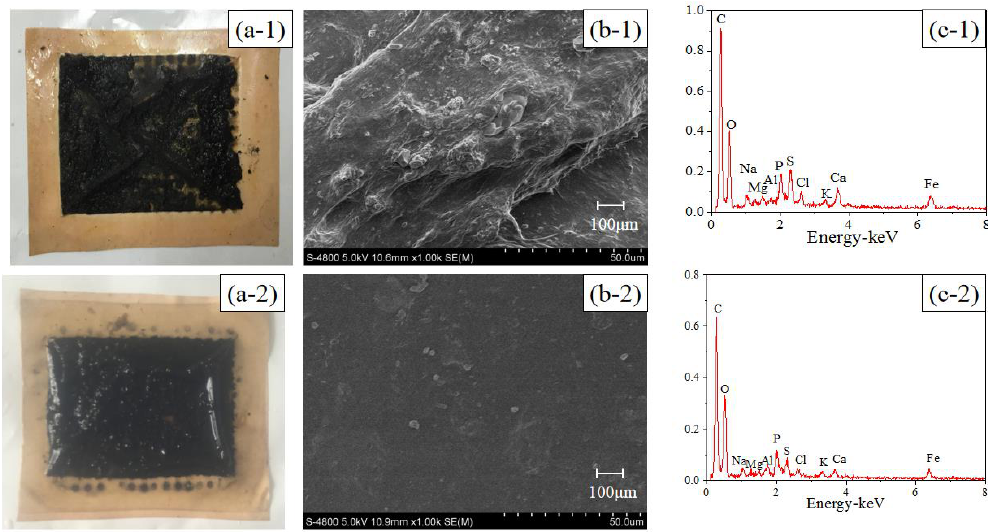
Figure 6. Photos ( a ) SEM and ( b ) EDX; ( c ) results of (1) the fouled pristine membrane and (2) the modified TFC–FO